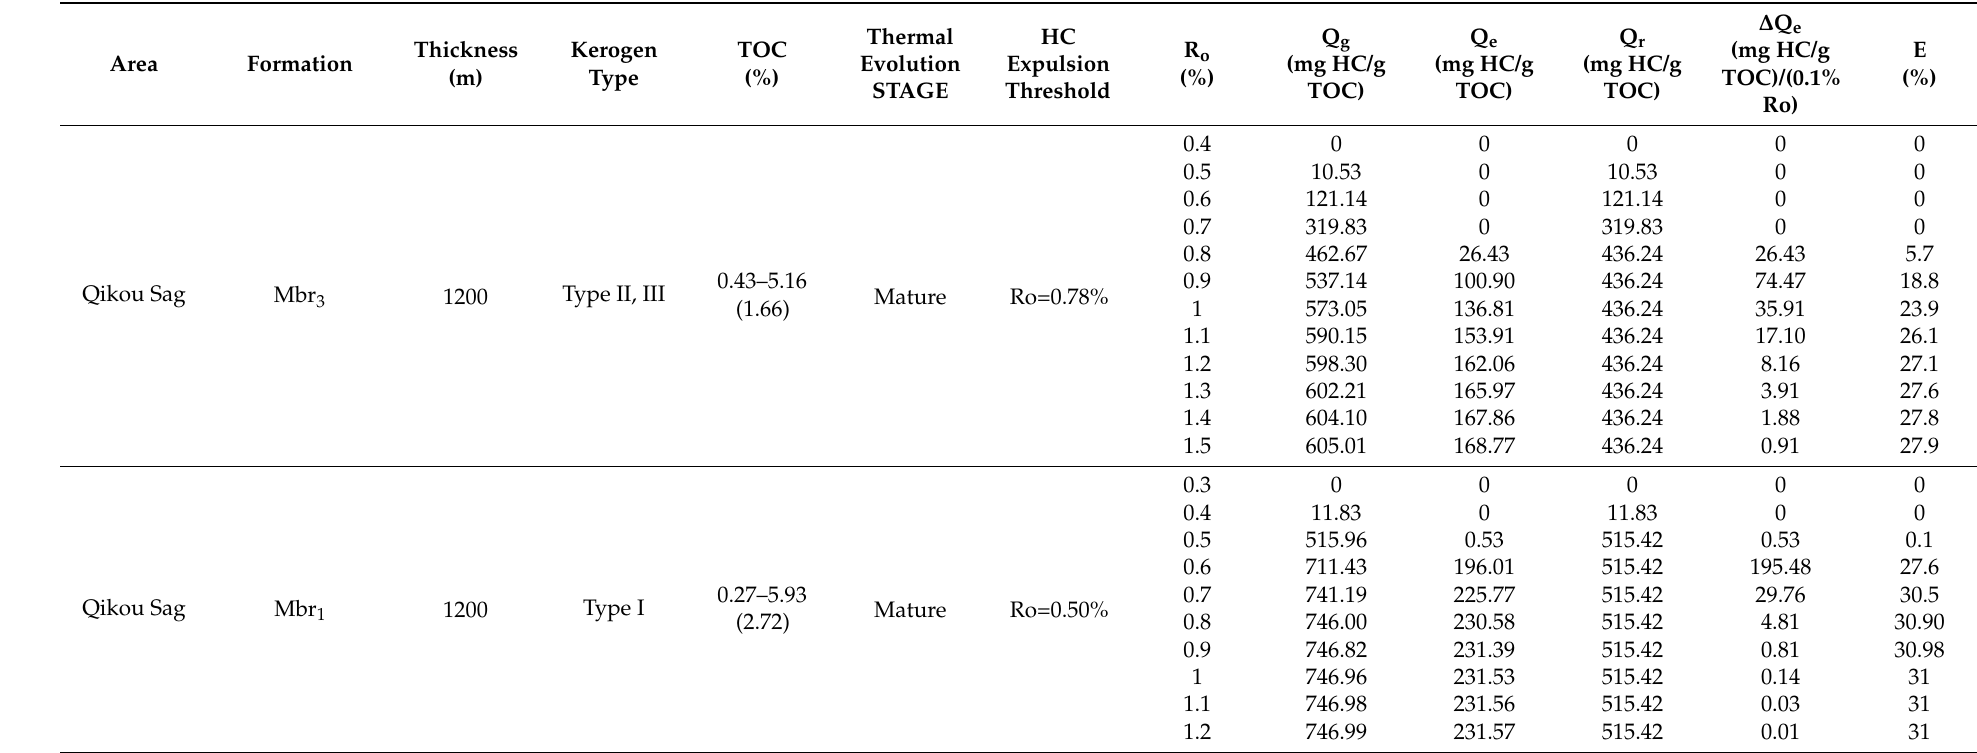
Table 1. Comparison on Mbr 1 and Mbr 3 source rocks in the Qikou Sag (Data cited from